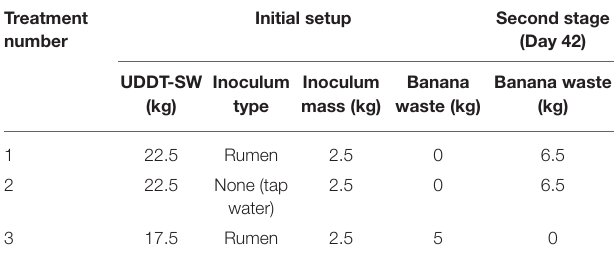
TABLE 2 | Treatment summary for field-scale trial (Experiment 3). Treatment